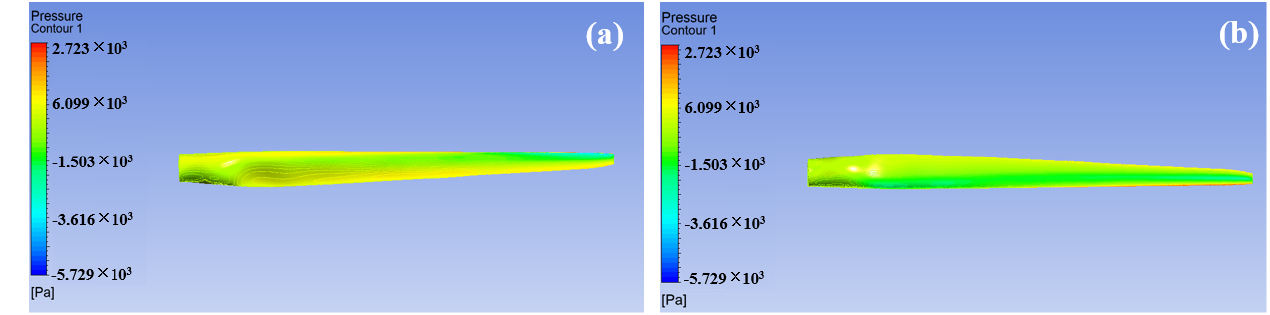
Figure 3. ( a ) Pressure surface contour. ( b ) Suction surface